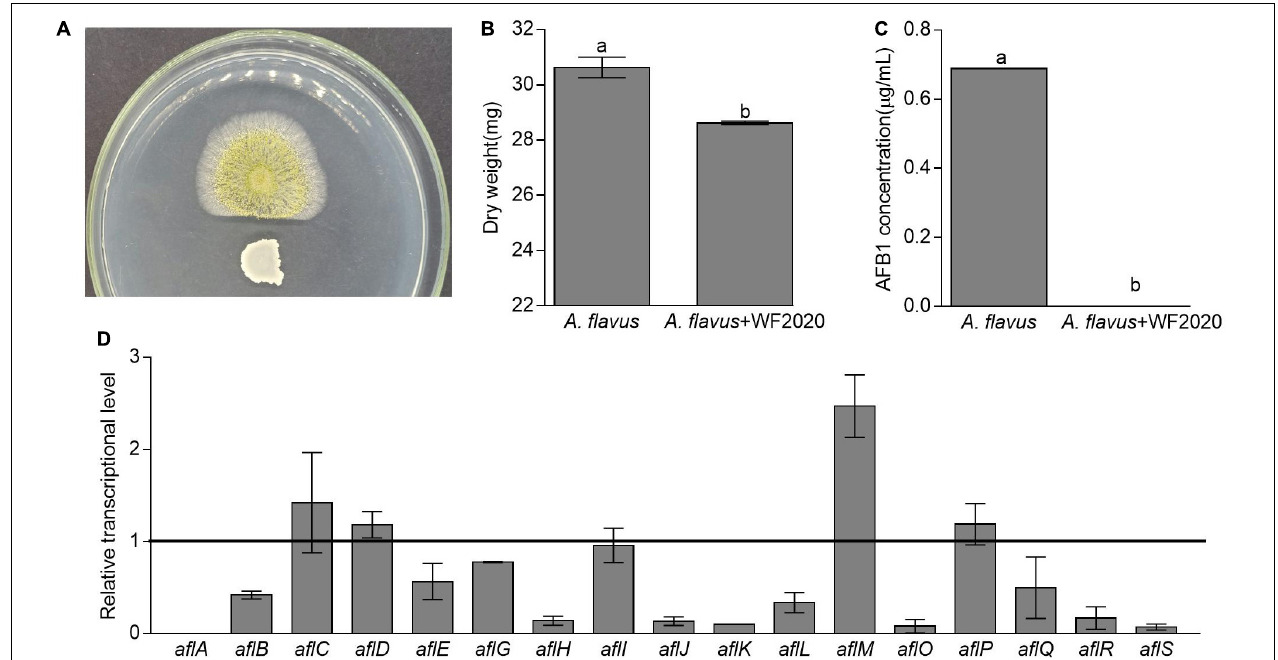
FIGURE 5 | Changes in fungal growth, AFB1 production, and transcriptional expression of genes involved in AFB1 synthesis in Aspergillus flavus . (A) The antagonistic effect of B. amyloliquefaciens WF2020 on fungal growth after the bacterium was co-incubated with A. flavus for 2 days on a plate of potato dextrose agar (PDA). (B,C) The reduction of dry weight (B) and AFB1 production (C) caused by B. amyloliquefaciens WF2020 after the bacterium was co-incubated with A. flavus for 2 days in the potato dextrose broth (PDB). (D) Quantitation of relative transcriptional levels of selected genes associated with AFB1 synthesis in A. flavus via real-time quantitative polymerase chain reaction (qRT-PCR) after B. amyloliquefaciens WF2020 was co-incubated with A. flavus for 2 days in PDB. The line represents the transcriptional levels of genes in control experiments, which were defined as 1. Different lowercase letters in the bars of each group indicate significant differences between treatments (Tukey’s test, p <